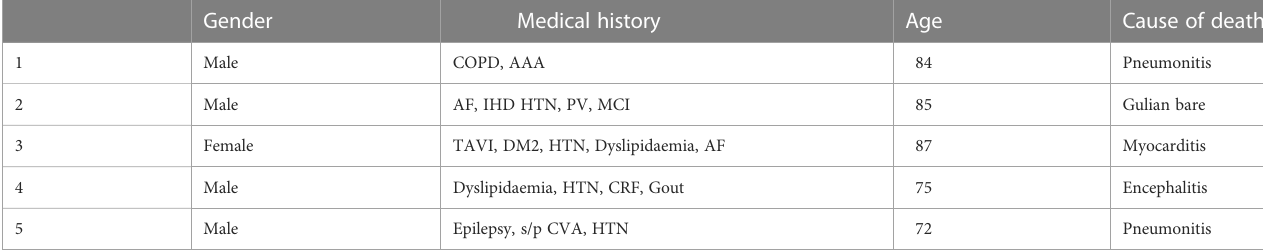
TABLE 2 Demographic characteristics of patients developed grade 5 toxicity.